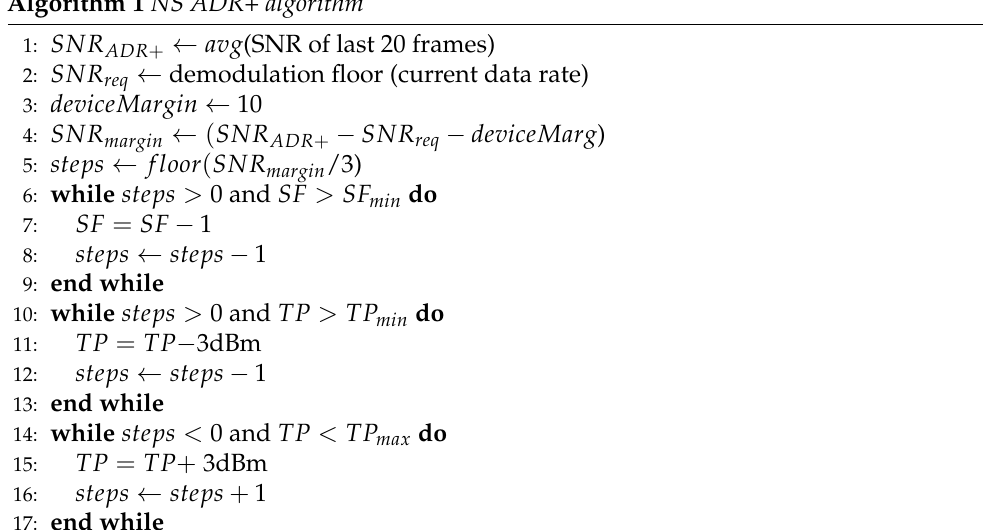
Algorithm 1 NS ADR+